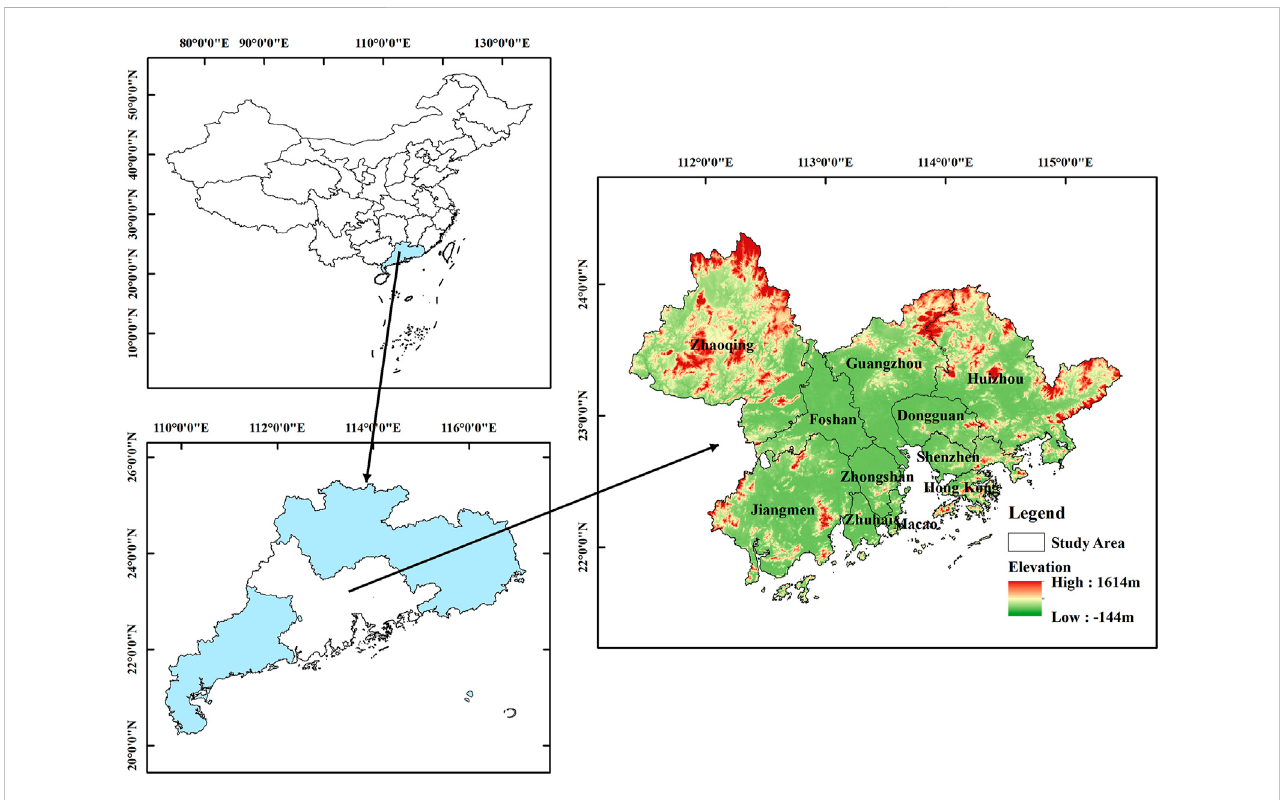
FIGURE 1 The geographical location of the study